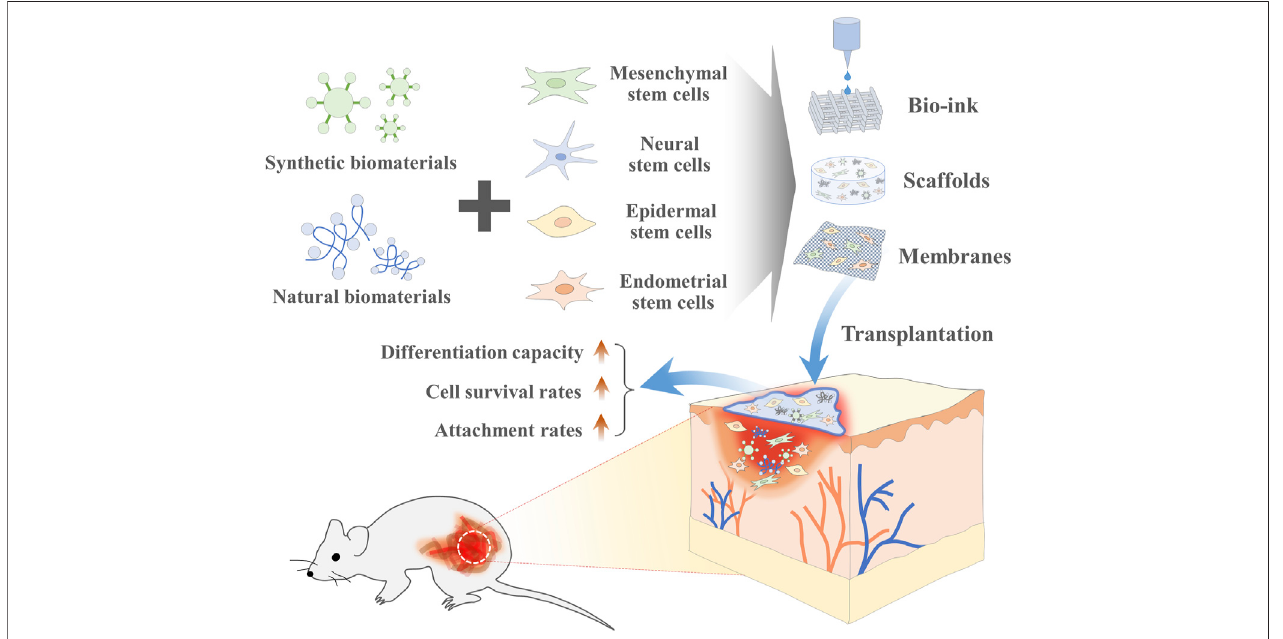
FIGURE 1 | The combination of stem cells and biomaterial-based tissue engineering can promote regenerative capacity of stem cells. Various synthetic or natural biomaterials-based 3-dimensional (3D) scaffolds can be used to overcome various current limitations of stem cells-based therapies by supporting their adhesion, survival, proliferation, and differentiation as well as providing elegant 3D tissue microenvironment at the sites of injury.